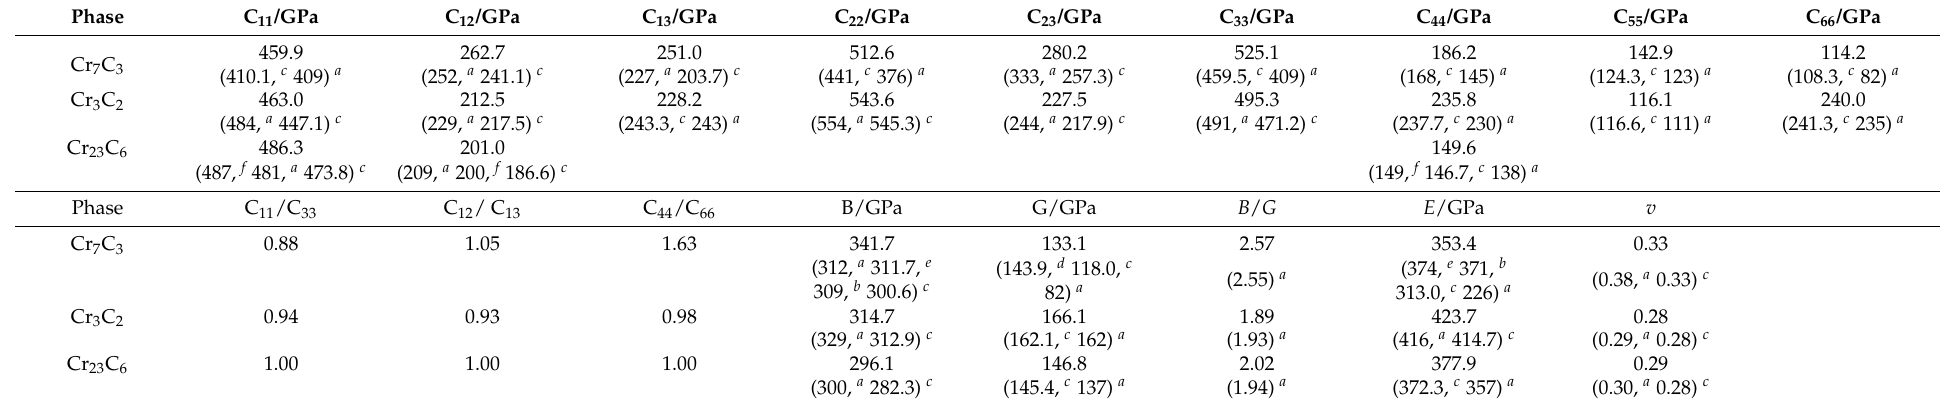
Table 2. Calculated values of the independent elastic constants (C ij ), C 11 /C 33 , C 12 / C 13 , C 44 / C 66 , bulk module (B , GPa), shear module ( G , GPa), Young module ( E , GPa), and Poisson’s ratio ( v ) at zero